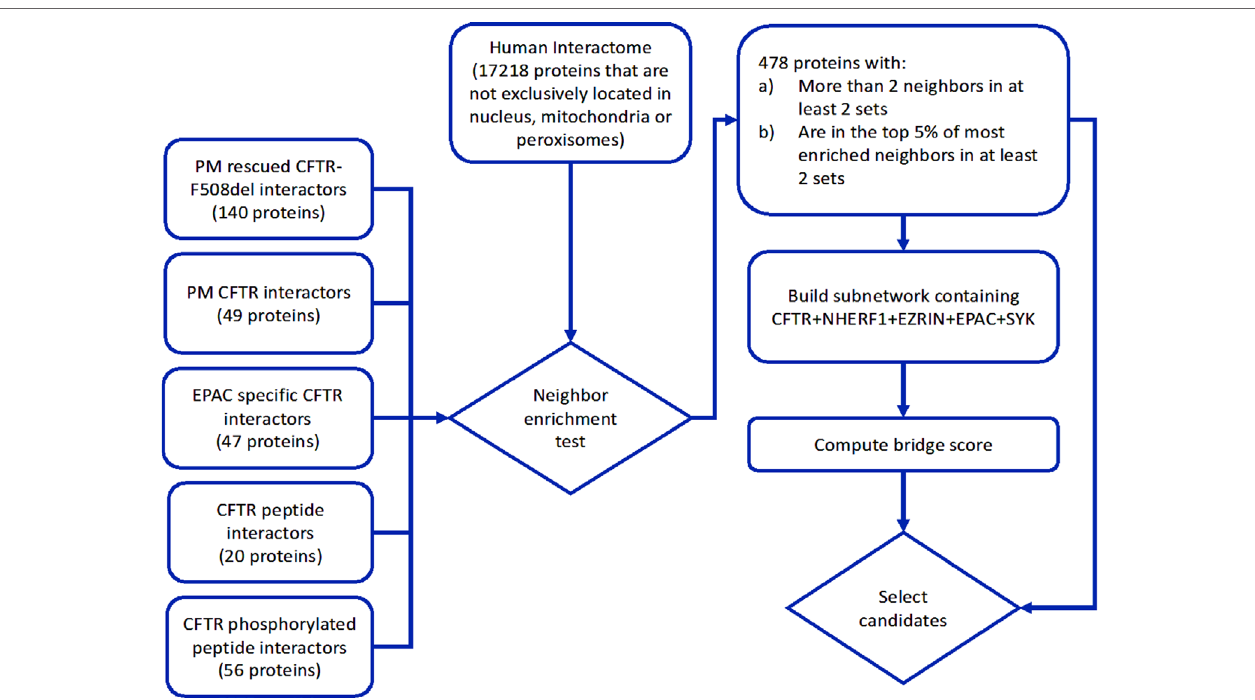
FIGURE 1 | Diagram of the network analysis procedures. CFTR interactor sets were mapped on a human protein physical interaction network, filtered for protein subcellular location to guarantee plausible interactions with CFTR. Proteins in the network were submitted to a neighbor enrichment test to select specific common neighbors of the CFTR interactor sets. A subnetwork containing the selected specific neighbors, CFTR, and related stability factors (EPAC, NHERF1, EZRIN, and SYK) was assembled and a bridge score was computed to identify strong network mediators of CFTR interaction with the referred stability factors. The ranking of neighbor specificity and bridge score were used to select candidates for experimental validation of CFTR PM stability